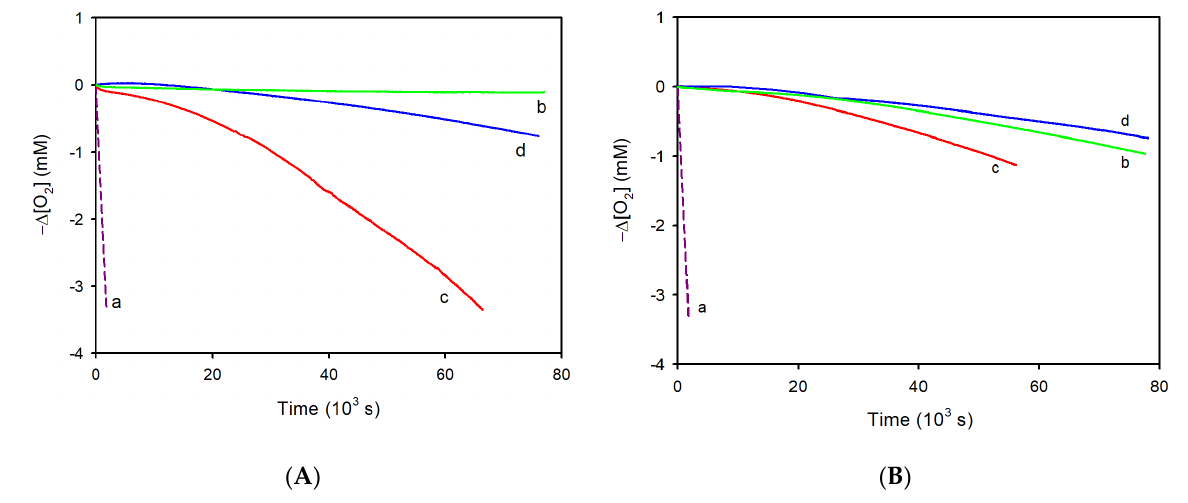
( B ) Figure 4 . Oxygen consumption measured during the autoxidation of styrene (4.3 M) in MeCN, initiated by AIBN (25 mM) at 30 °C, in the absence of inhibitors (a, dashed line) or in the presence of the investigated antioxidants: Panel ( A ): MAG-NDGA (b), MAG-GA (c), MAG-TX (d), bare MAG (e), (all 0.25 mg/mL); Panel ( B ): NDGA (0.082 mM) (b), GA (0.18 mM) (c), TX (0.065 mM) (d), corresponding to the phenol concentration of the experiments reported in Panel ( A ). Inset in Panel ( A ) reports the O 2 consumption during the autoxidation of styrene (4.3 M) in MeCN in the presence of MAG (0.25 mg/mL) and 10 mM of different peroxides.